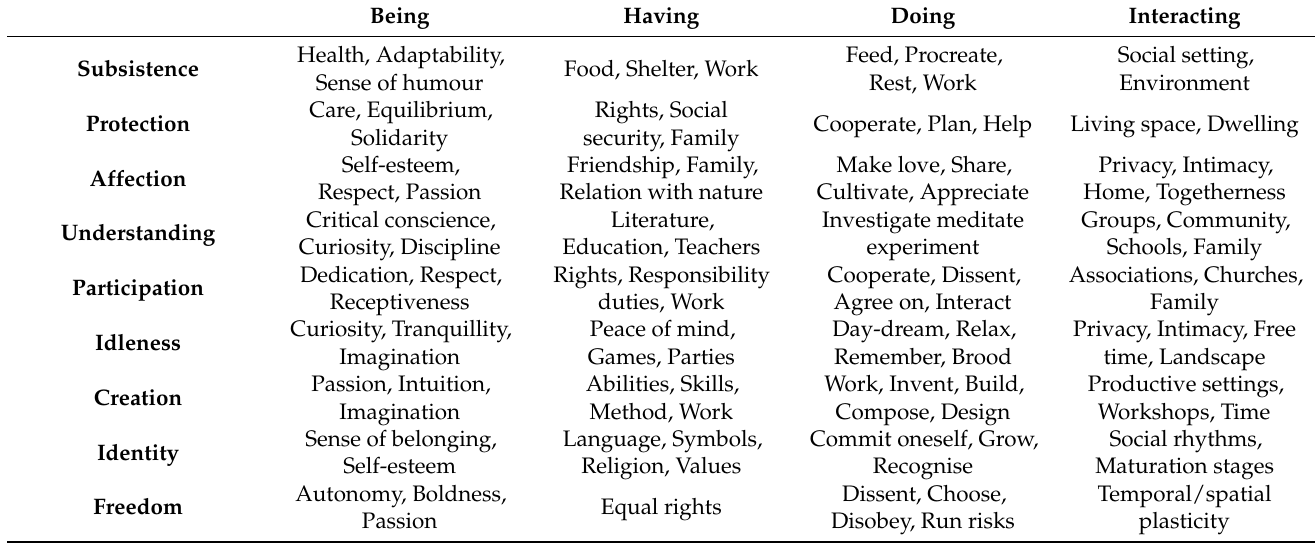
Table 2. Matrix of Needs and